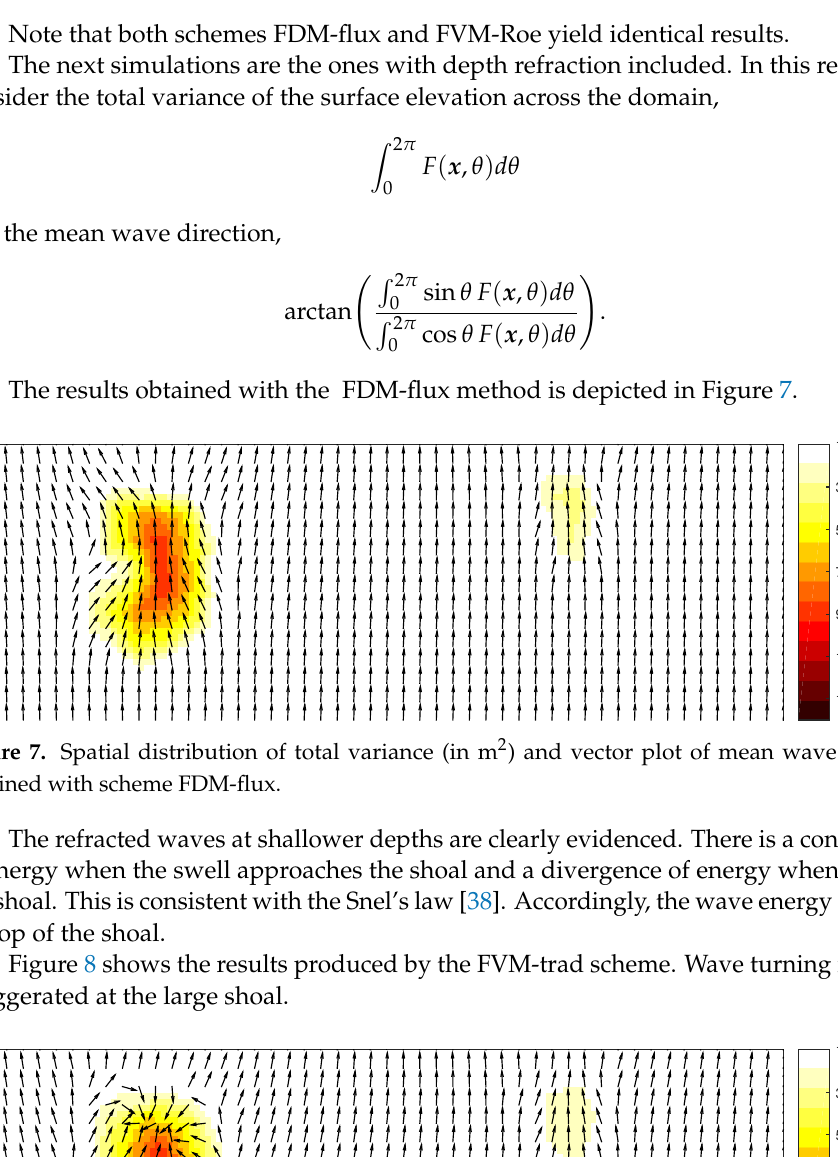
Figure 6. Spatial distribution of shoaling coefficient obtained with scheme FVM-Roe.